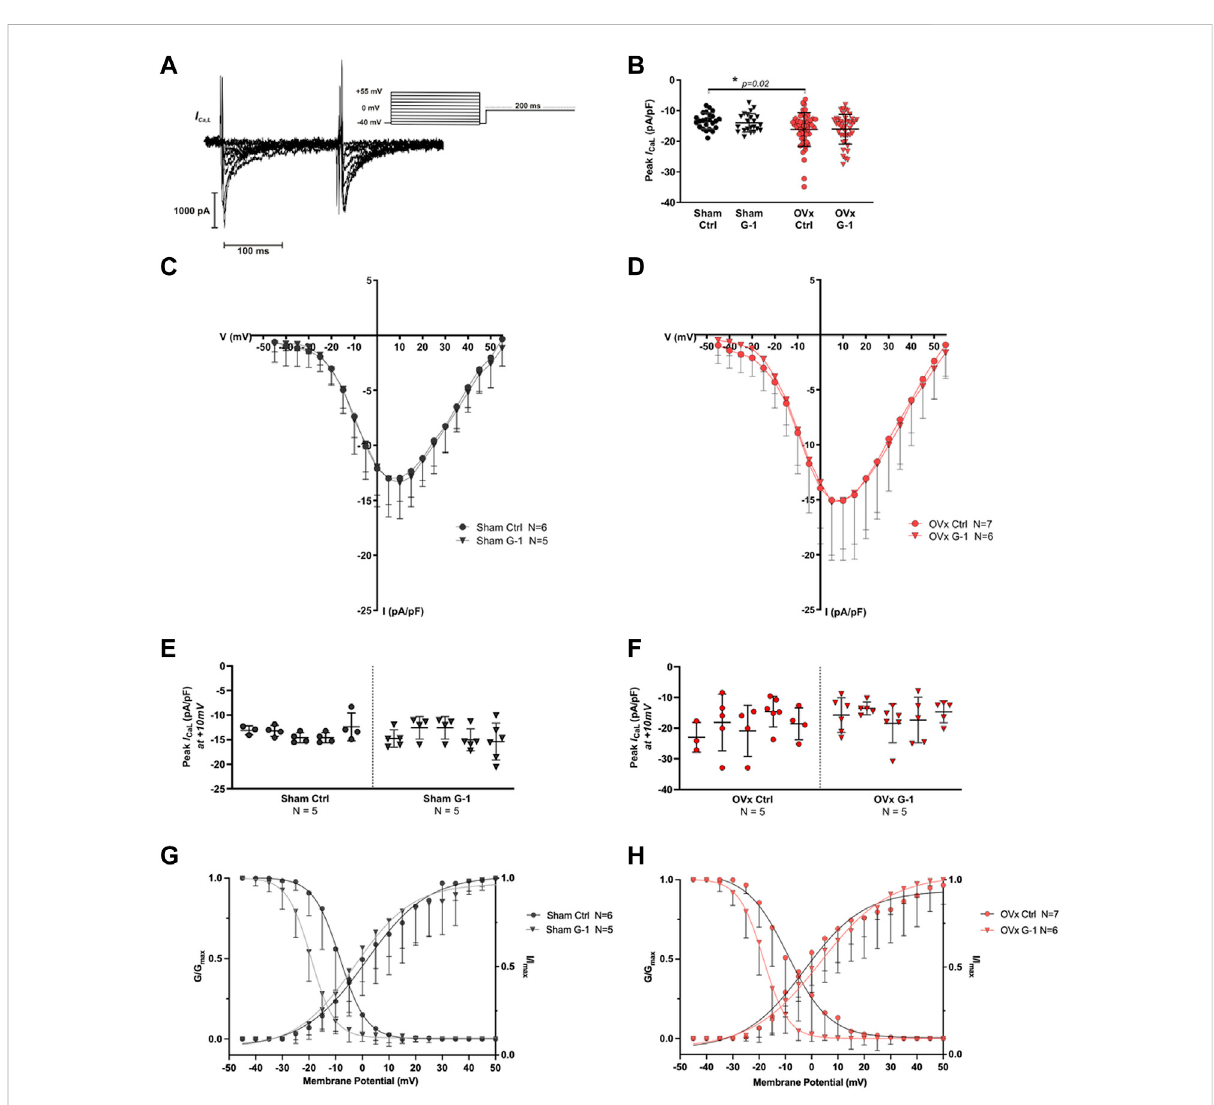
FIGURE 3 The effect of GPER activation on L-type Ca 2+ channel (LTCC) current ( I Ca,L ). (A) Voltage-clamp step protocol to measure the current-voltage (I – V) relationship of the LTCC and representative cadmium-sensitive current trace. (B) The peak I Ca,L at +10 mV was higher in OVx; however, peak I Ca,L was unchanged following GPER activation. (C) I-V relationship of sham ± G-1 and (D) of OVx ± G-1. Mean ± SD. One-way ANOVA. * valueasindicated.Shamctrln/N=23/6,shamG-1n/N=21/5;OVxctrln/N=51/7,OVxG-1n/N=45/6. (E) Nestedanalysesofpeak I Ca,L insham and (F) OVx cardiomyocytes in ctrl and G-1 conditions. Mean ± SD. Nested t -test. Sham ctrl n/N = 19/5, sham G-1 n/N = 24/5; OVx ctrl n/N = 22/5, OVx G-1 n/N = 25/5. (G) LTCC voltage-dependent activation (G/G max ) and inactivation (I/I max ) curves plotted for sham ± G-1 and (H) OVx ±